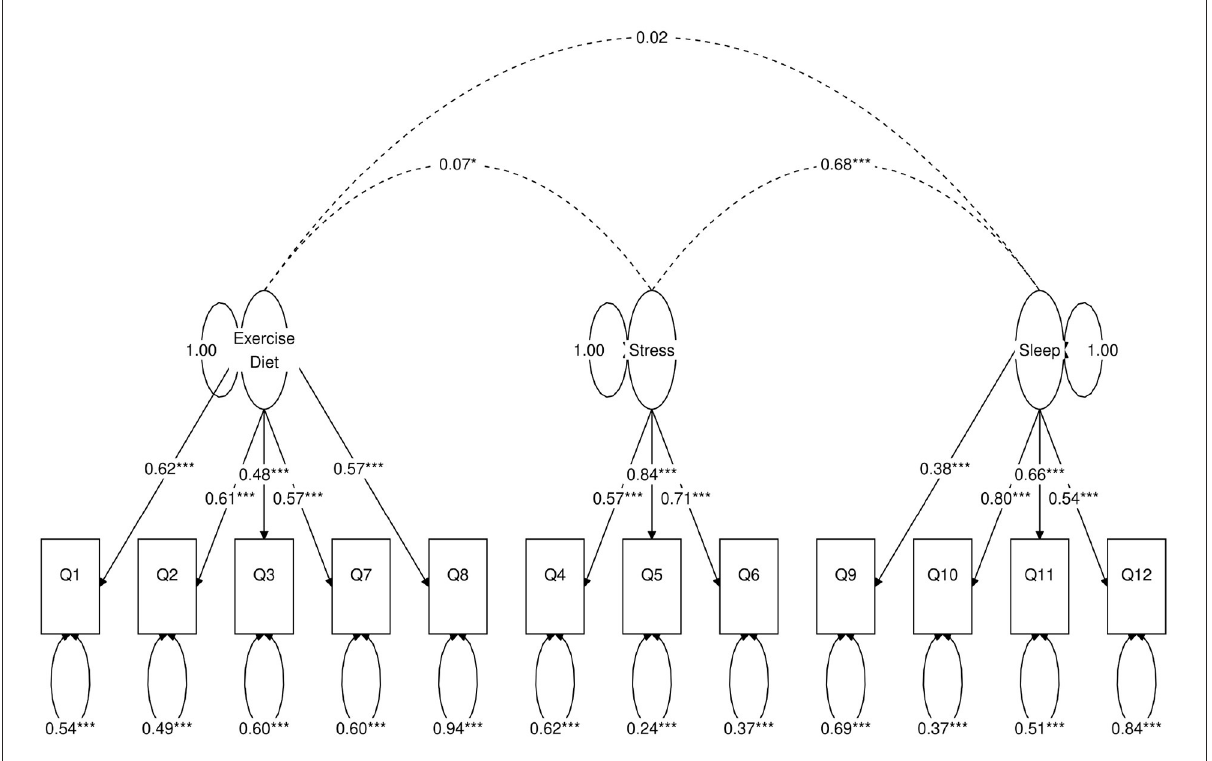
FIGURE3 Path diagram of the three-factor CFA model. Star conventions as in Figure